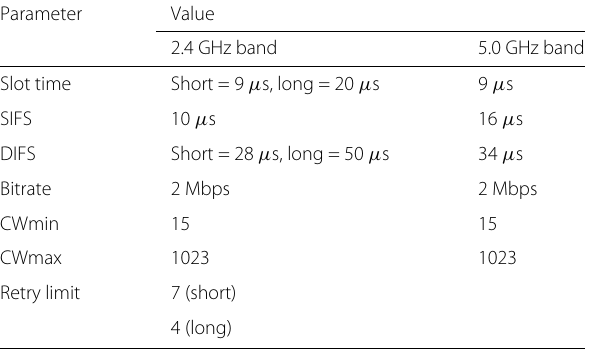
Table 10 IEEE 802.11 parameters [146]